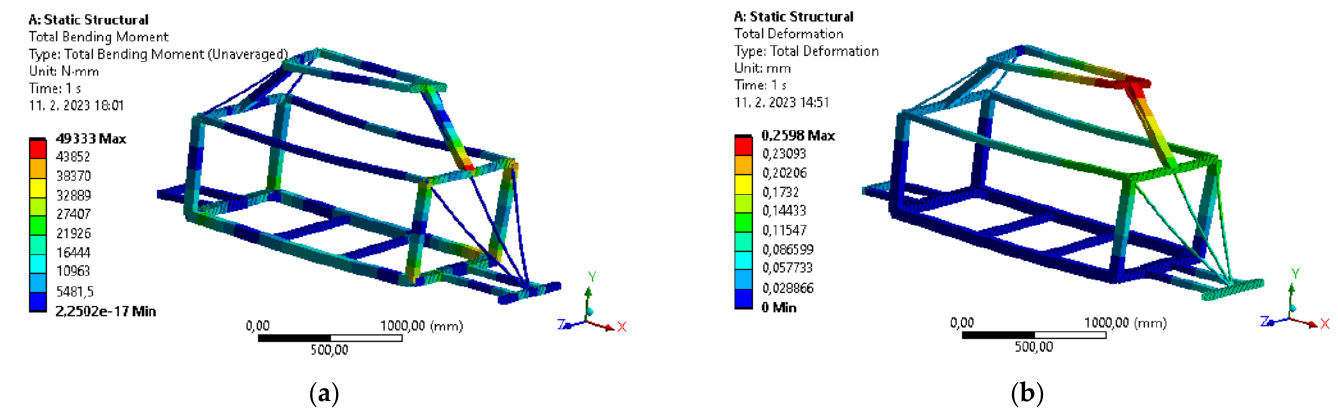
Figure 4. ( a ) Course of the bending moment; ( b ) course of